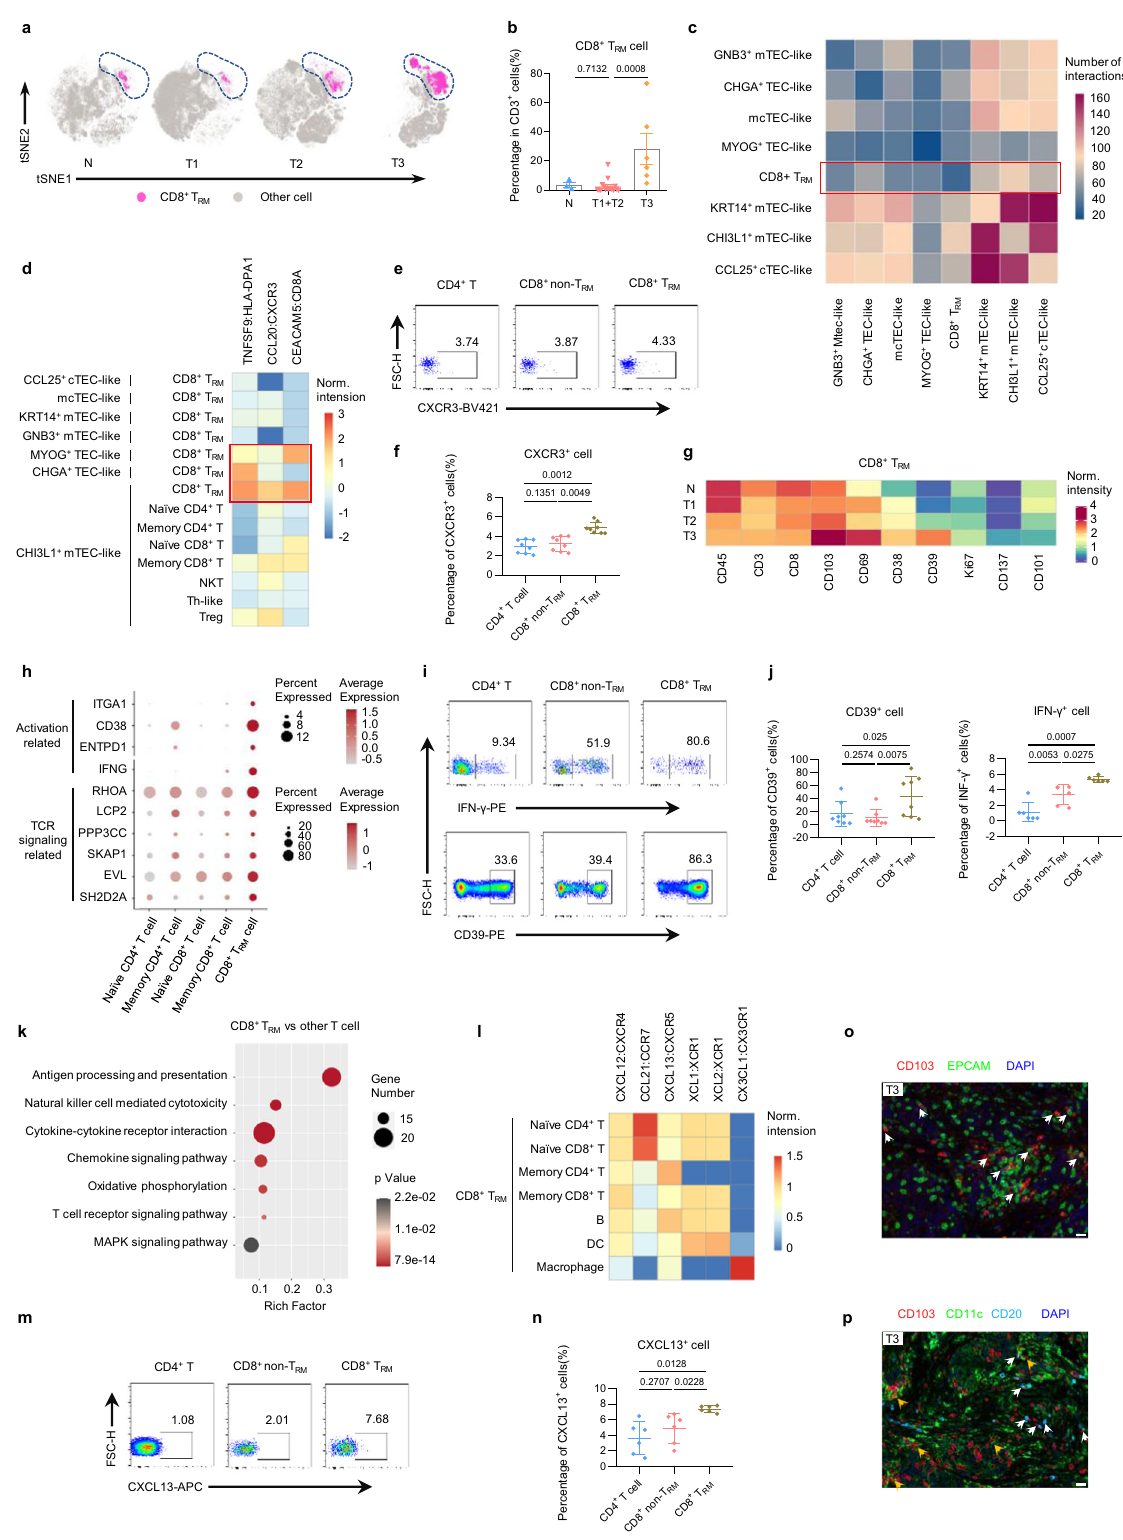
SH2D2ASKAP1Activation